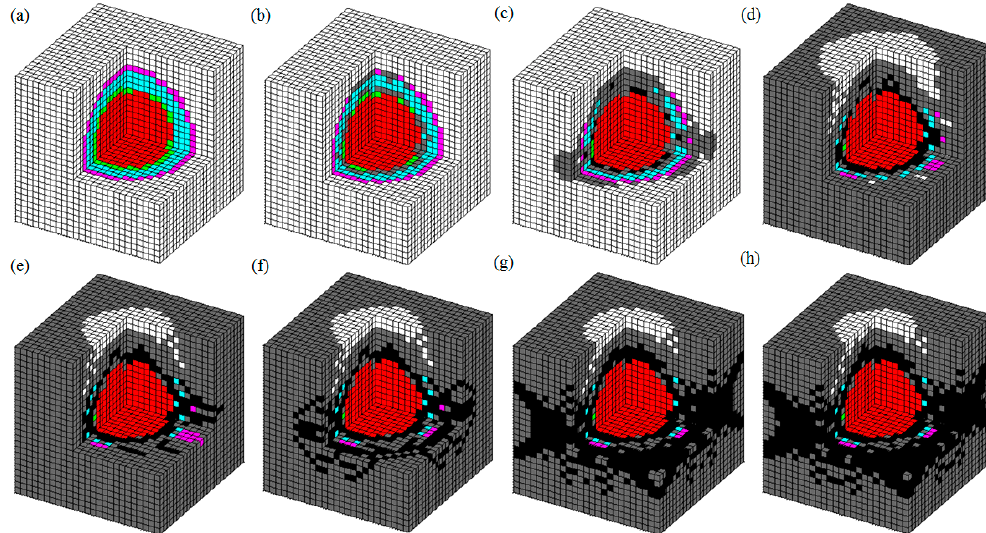
Figure 8. Failure pattern of RAC. ( a ) Initial model; ( b ) Elastic deformation; ( c ) First crack; ( d ~ f ) Crack propagation; ( g , h ) Continuous cracks.